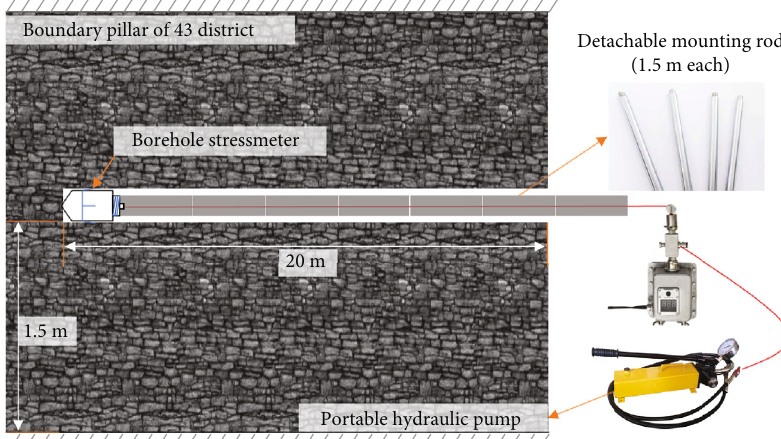
Figure 6: Installation of borehole stress